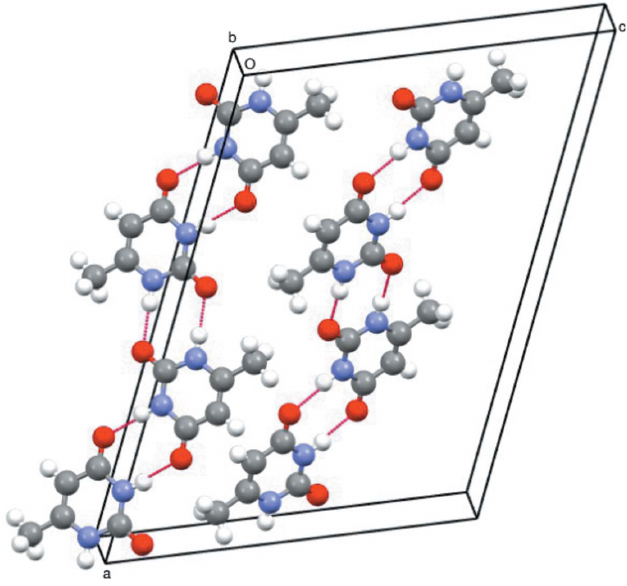
down b . All atoms are shown as small spheres of arbitrary radii. Hydrogen bonding is indicated by red dashed lines.